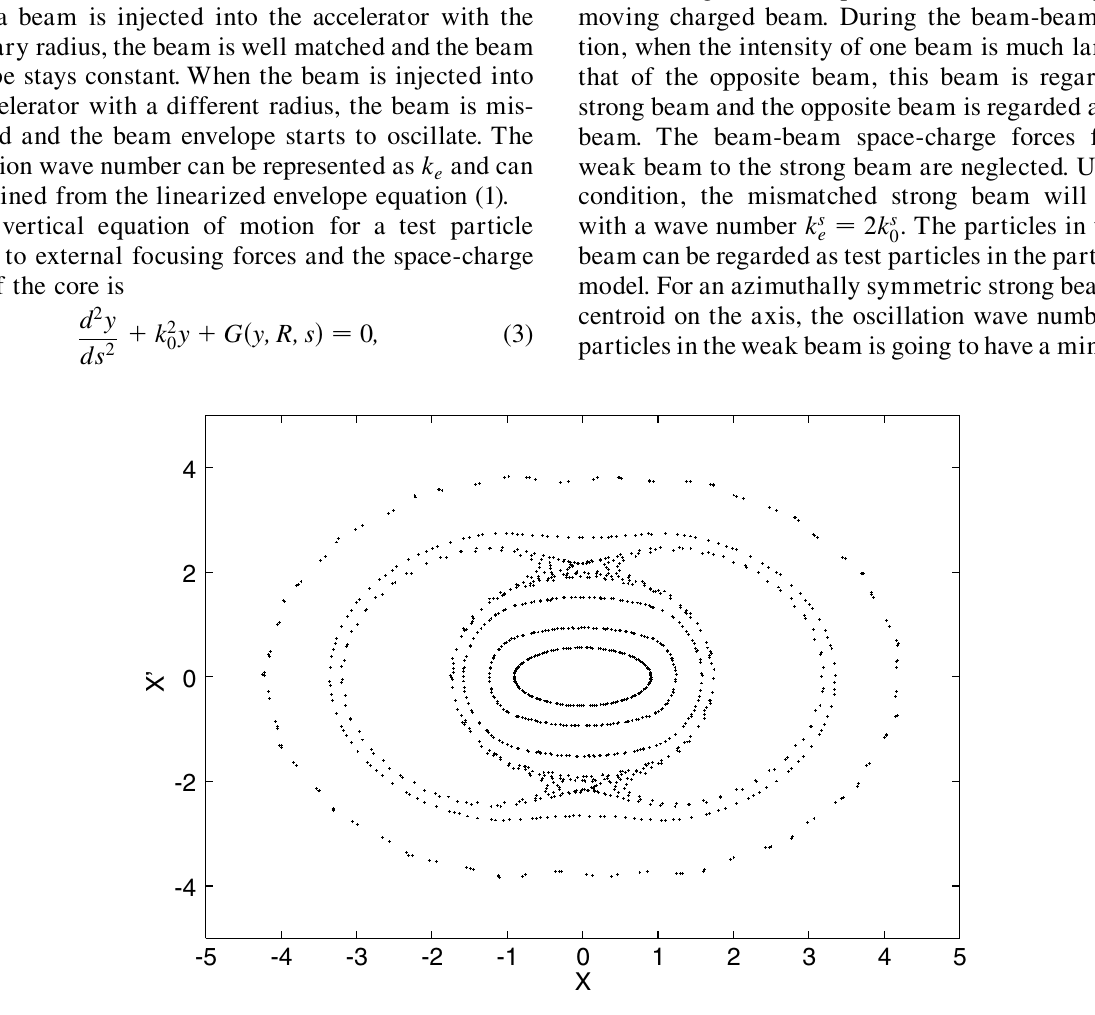
FIG. 1. A stroboscopic plot of the 1:2 resonance in the x - x 0